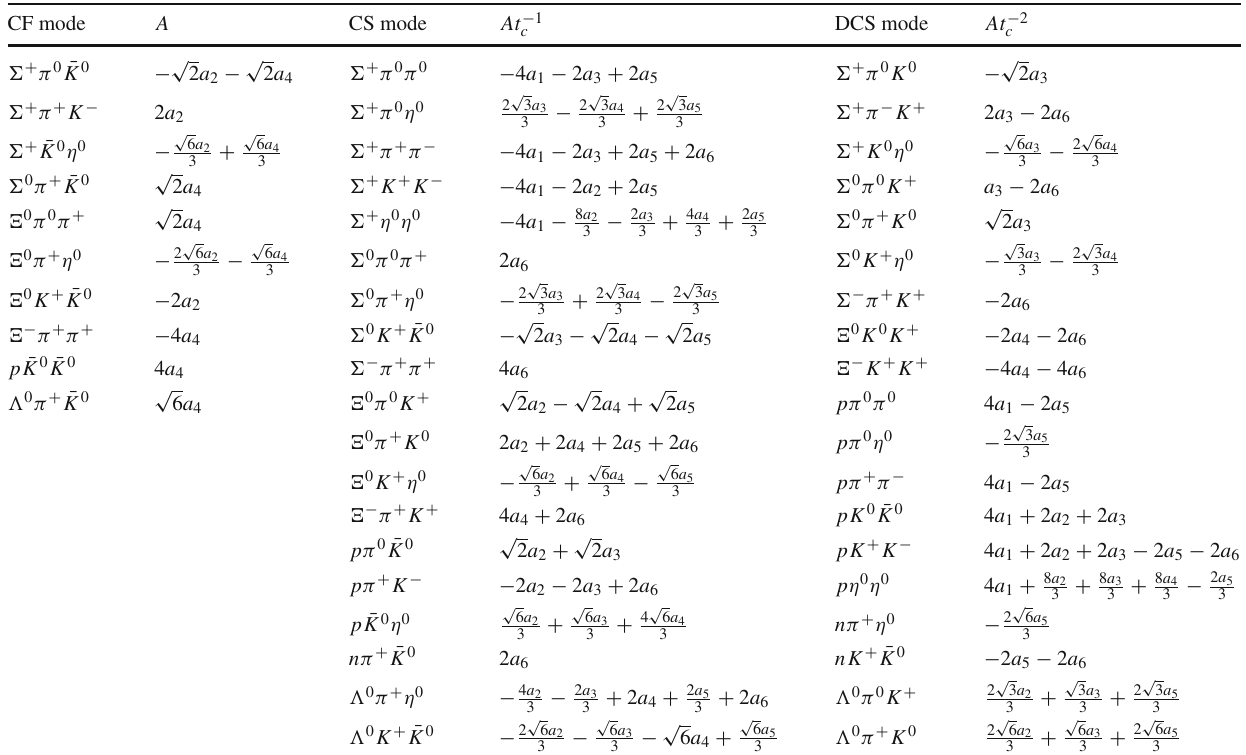
Table 2 A-amplitudes of (cid:2) + c → B n MM (cid:3)